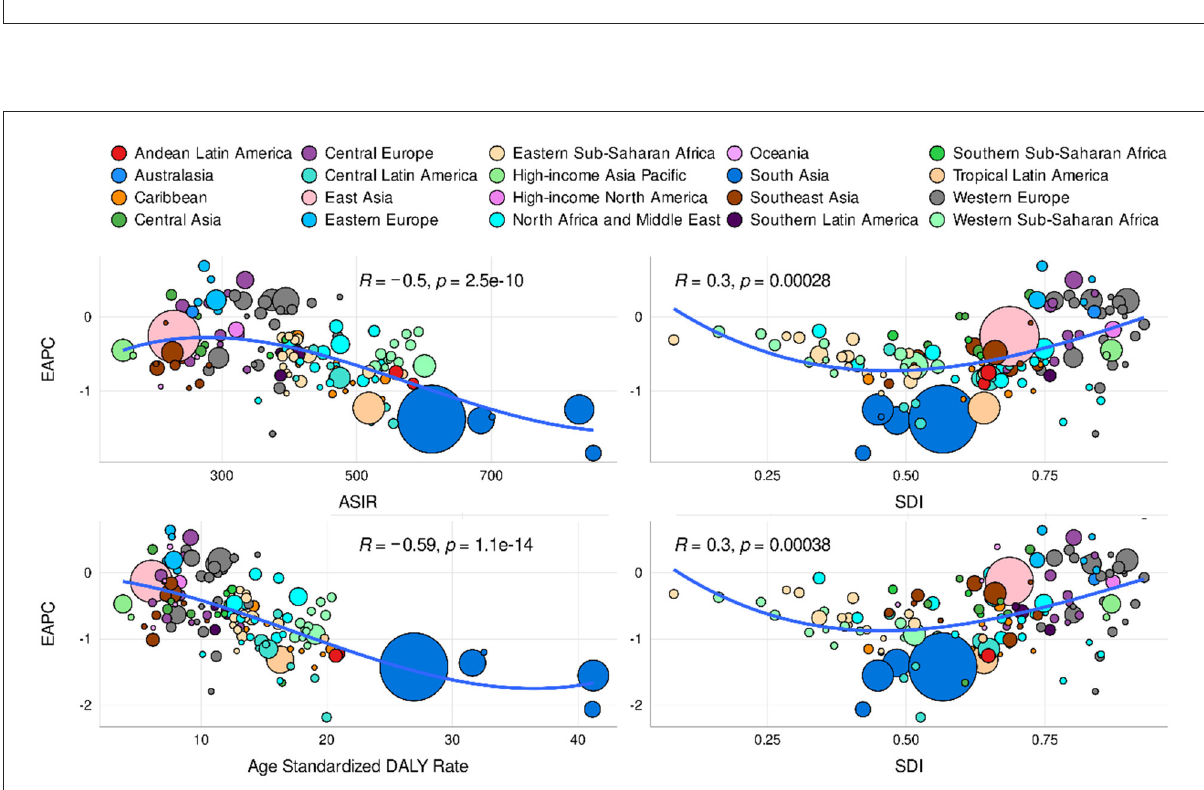
FIGURE3 Distribution of DALYs in different SDI regions. (A) Distribution of DALYs of different age proportions in different SDI regions from 1990 to 2019. Distribution of (B) DALY and (C) EAPC-DALY in various countries and regions in 2019.